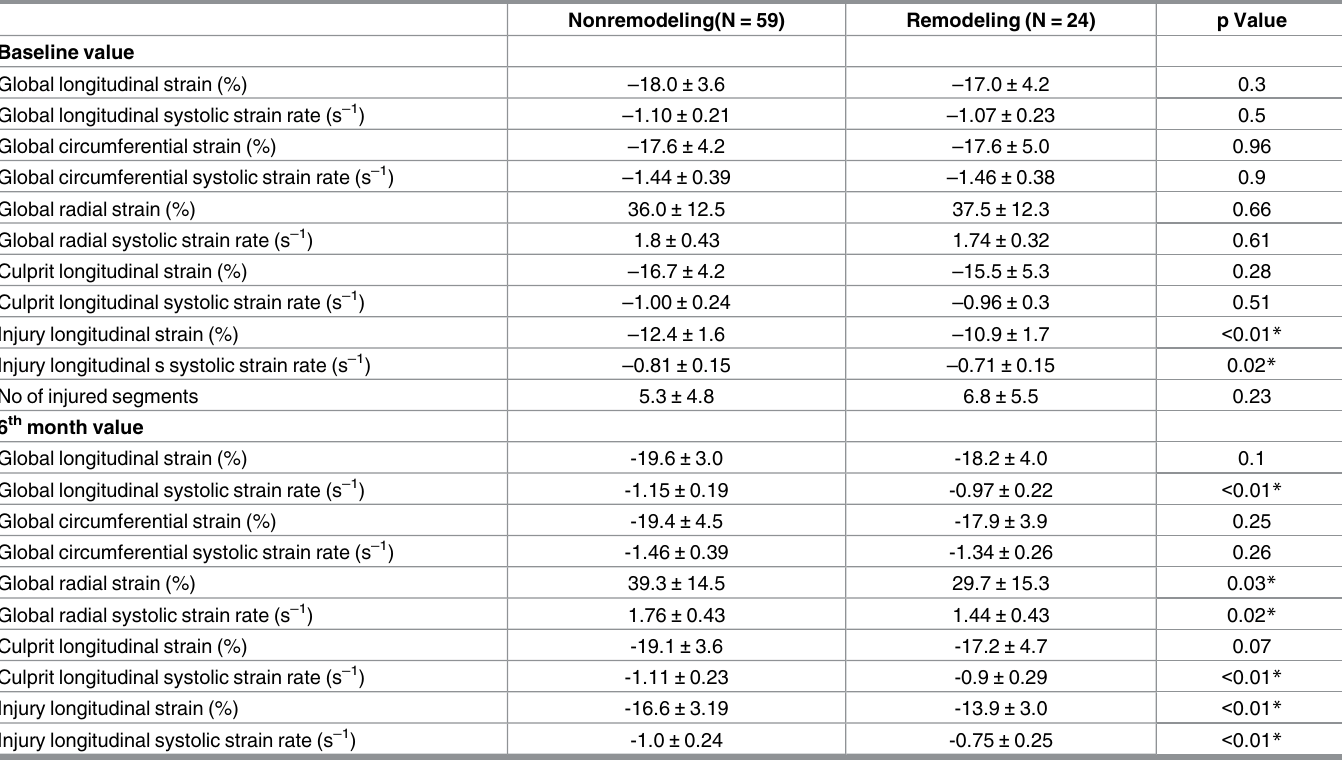
Table 3. Left ventricular deformation performance indices.